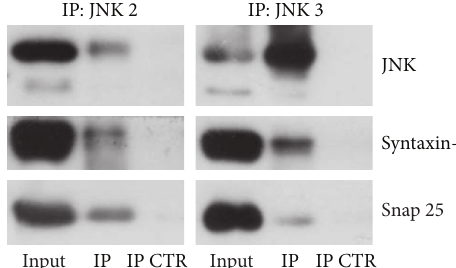
Figure 5: Both JNK2 and JNK3 interact with Syntaxin-2 and Snap25. Western blotting after immunoprecipitation of JNK2 (left) and JNK3 (right) on purified synaptosomes lysates extracted from adult mice cortex. Syntaxin-2 and Snap25 were detectable both in JNK2 and in JNK3 precipitate. 500 𝜇 g of total lysates has been subjected to immunoprecipitation, while 20 𝜇 g was loaded as control (each experimental group 𝑁 = 3